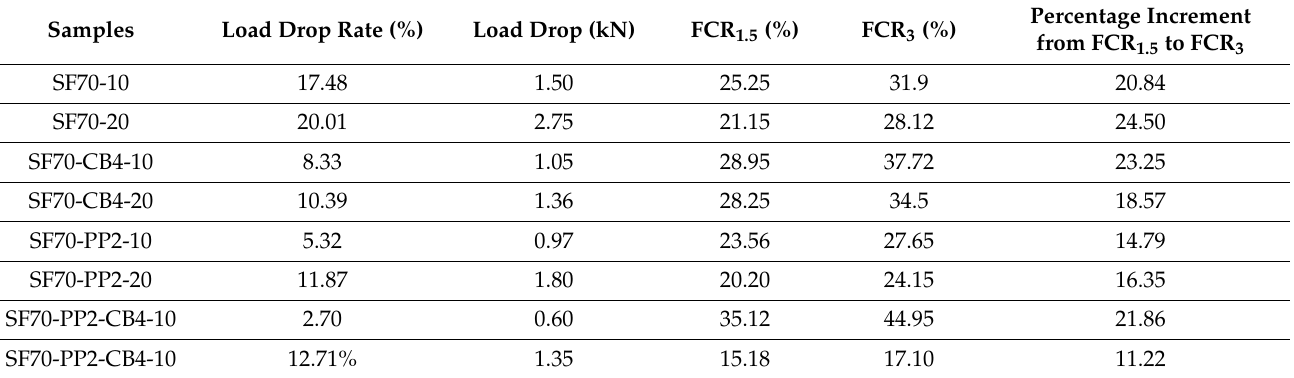
Table 4. Loading drop rate and percentage increment of